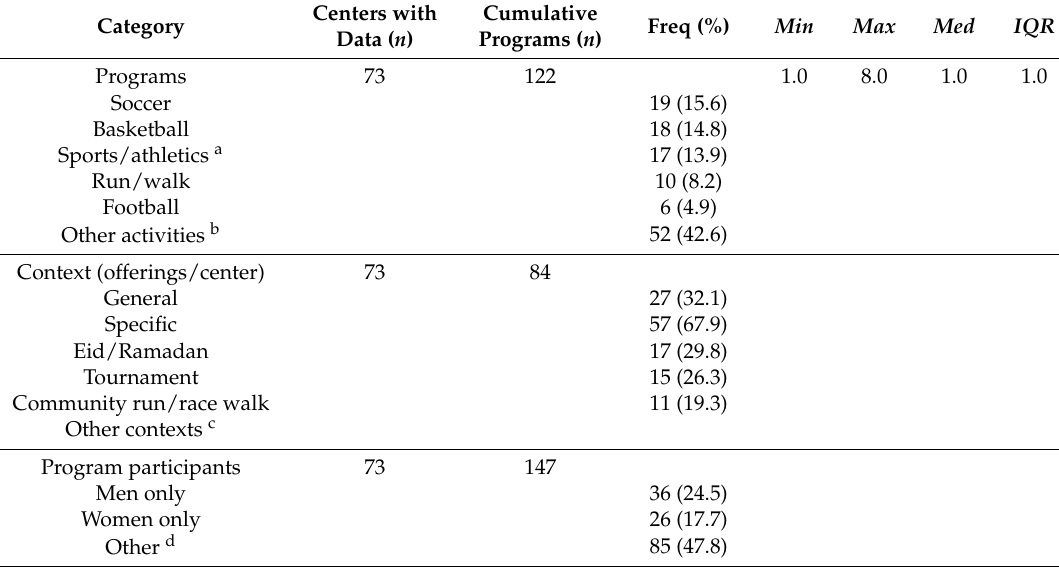
Table 5. Islamic center irregular program descriptive data ( n = 73